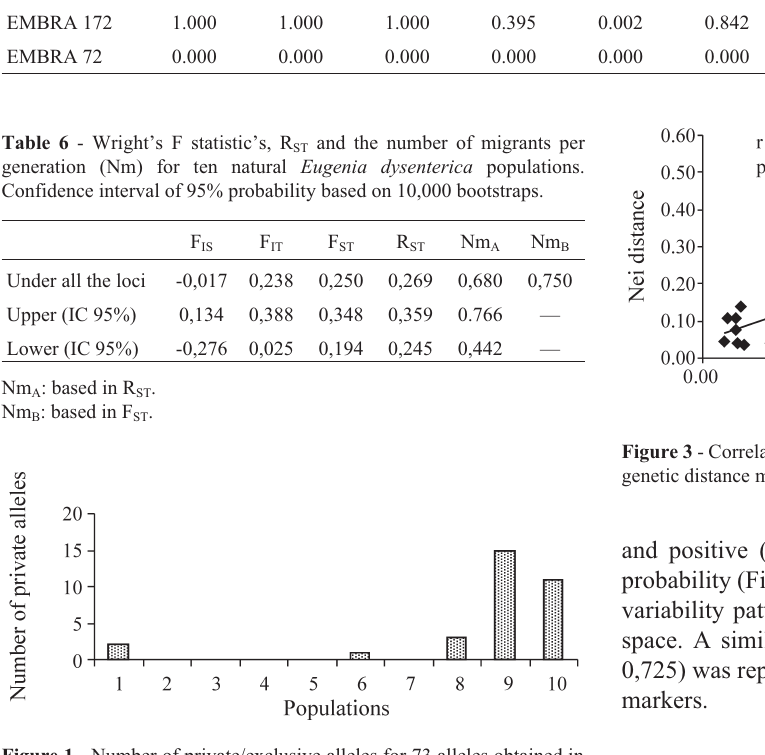
Figure 1 - Number of private/exclusive alleles for 73 alleles obtained in seven polymorphic loci of the SSR markers, in ten Eugenia dysenterica populations.